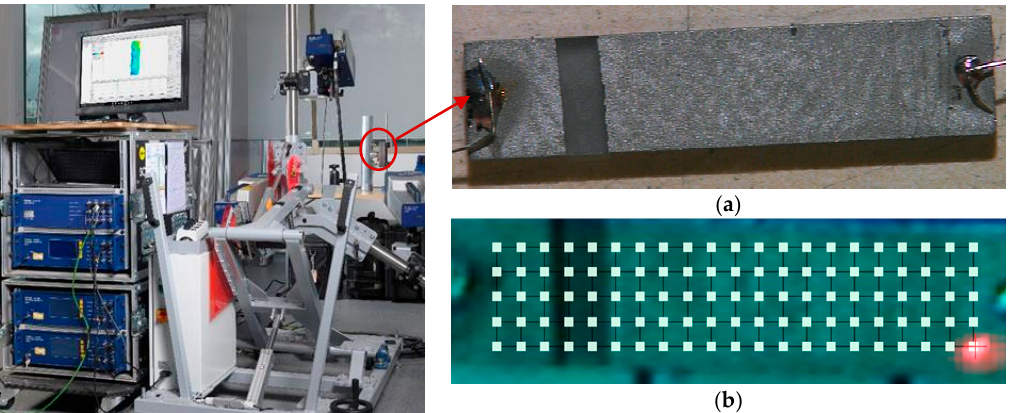
Figure 2. 3D-Laser Doppler Vibrometry experimental setup for measuring electrical displacement of ( a ) wraparound GaPO 4 element with ( b ) scan points used for 3D measurements.